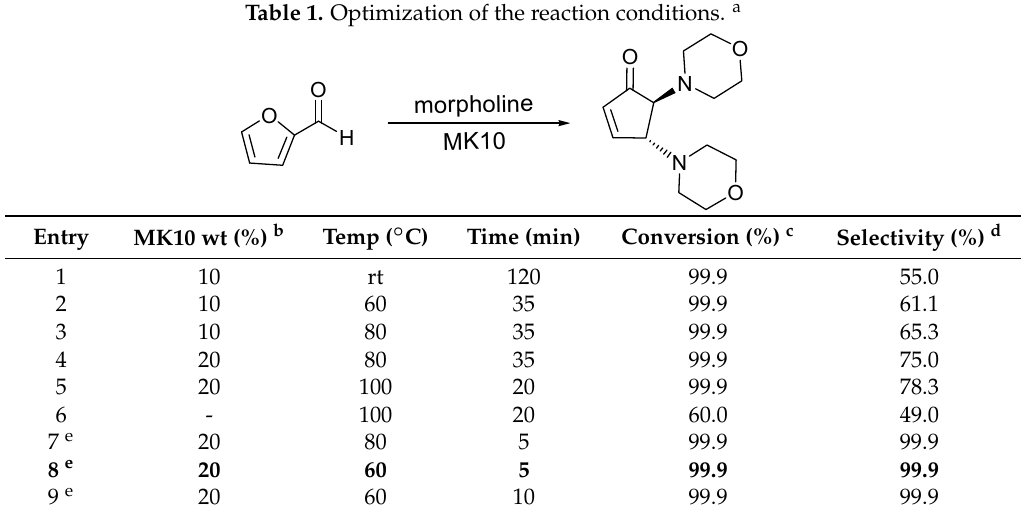
Table 1. Optimization of the reaction conditions. a